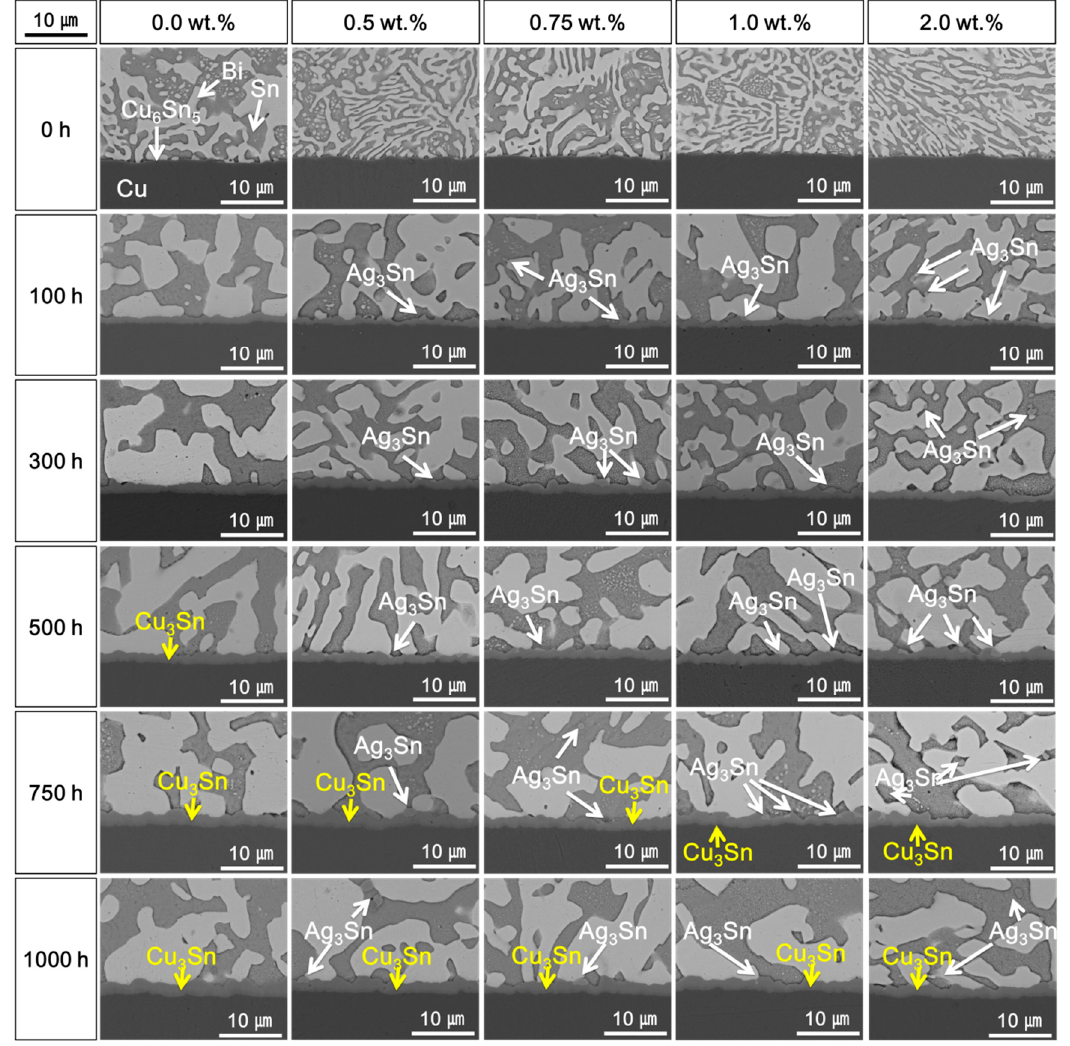
Figure 3. Cross-sectional scanning electron microscopy (SEM) micrographs of the Sn–58Bi Ag NP composite solder joints after high-temperature storage (HTS) tests at 100 °C.